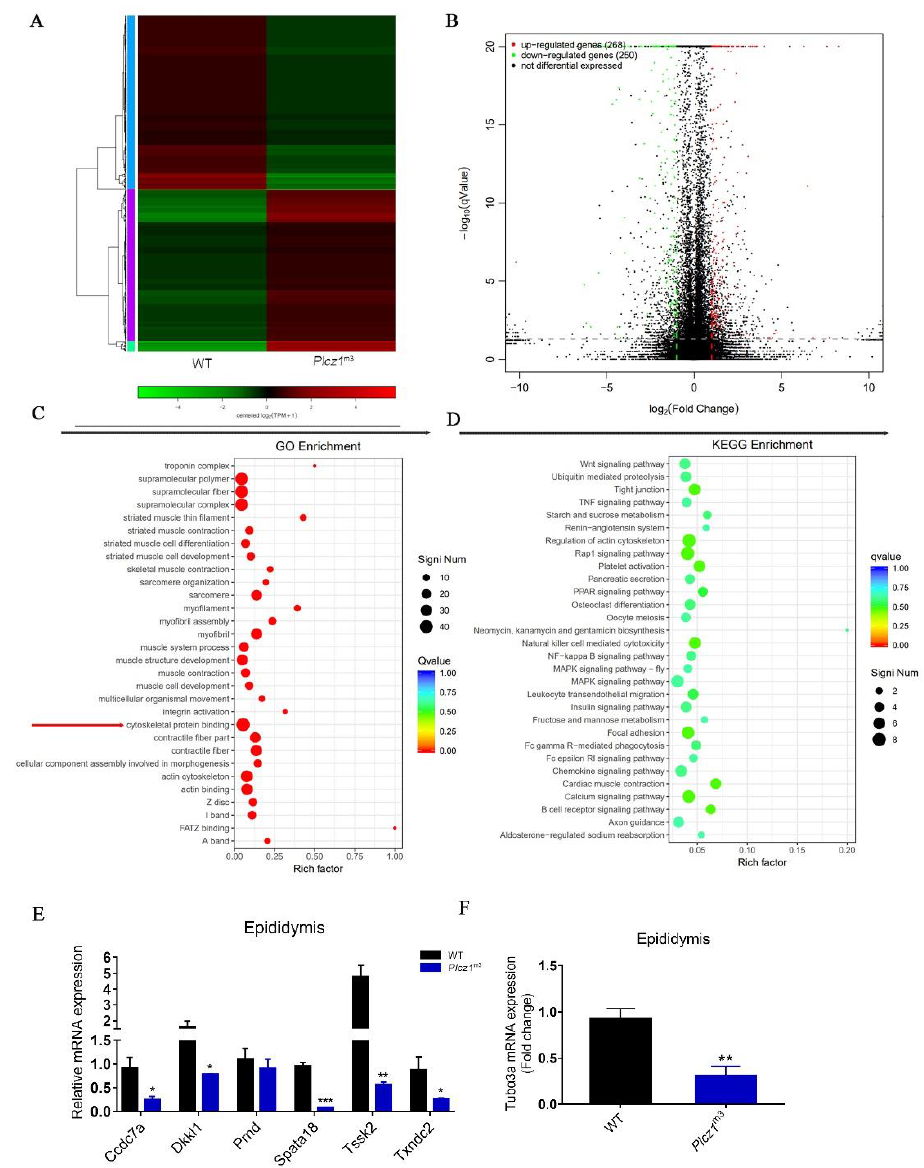
Figure 4. RNA sequencing analysis of cauda epididymis Plcz1 m3 mice. ( A ) Hierarchical clustering analysis of z-scored expression profiles of transcripts that were up-regulated or down-regulated between Plcz1 m3 and WT. ( B ) Volcano plot of unigenes in Plcz1 m3 compared with WT. ( C ) Functional gene ontology categories of differentially expressed genes between Plcz1 m3 and WT. ( D ) Scatter plot of differentially expressed genes enriched in KEGG pathways. The enrichment factor represents the ratio of the number of DEGs to the number of all the unigenes in the pathway; the q value represents the corrected p value. ( E , F ) Relative expression level of differentially expressed genes ( Ccdc7a , Dkkl1 , Pmd , Spata18 , Tssk2 , Txndc2 and Tuba3a ) in epididymis of Plcz1 m3 were detected by using RT-PCR (* p < 0.05, ** p < 0.01, *** p <